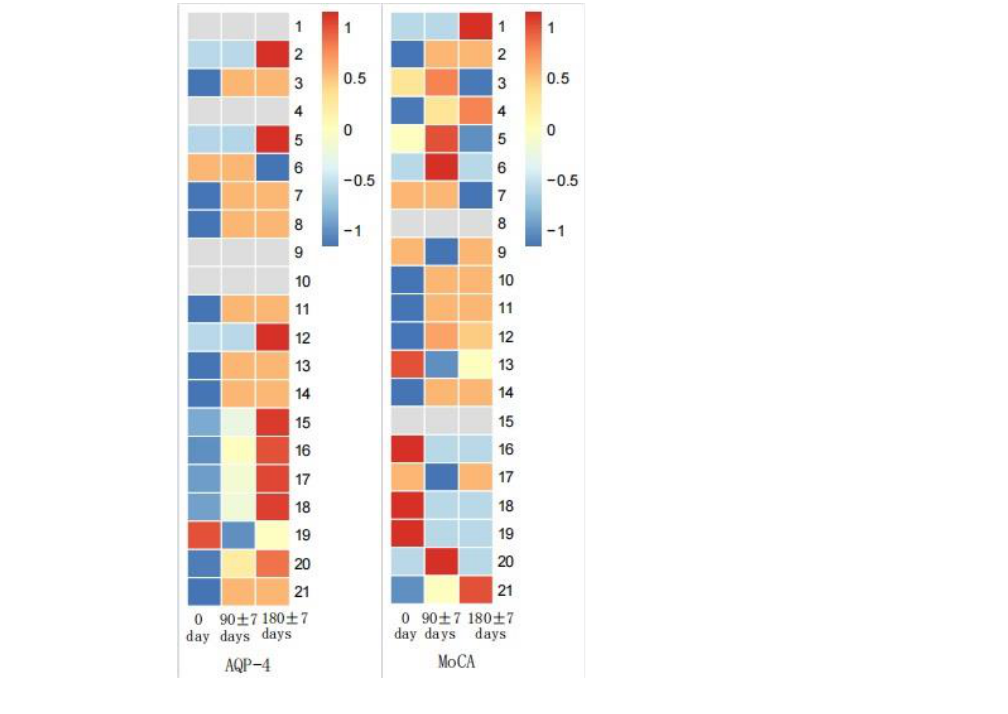
Figure 4. MoCA scores between acute and chronic NMOSD.